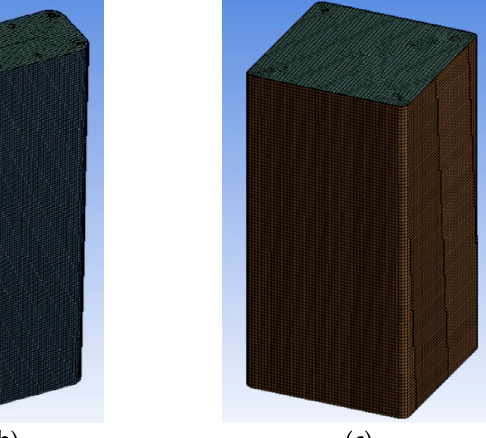
Figure 3. Mesh of specimens: ( a ) Series BS1C/BS2C by [2]; ( b ) Series R2.0H2CL by [28] and ( c ) Series LSR-R-1-3 by [20].